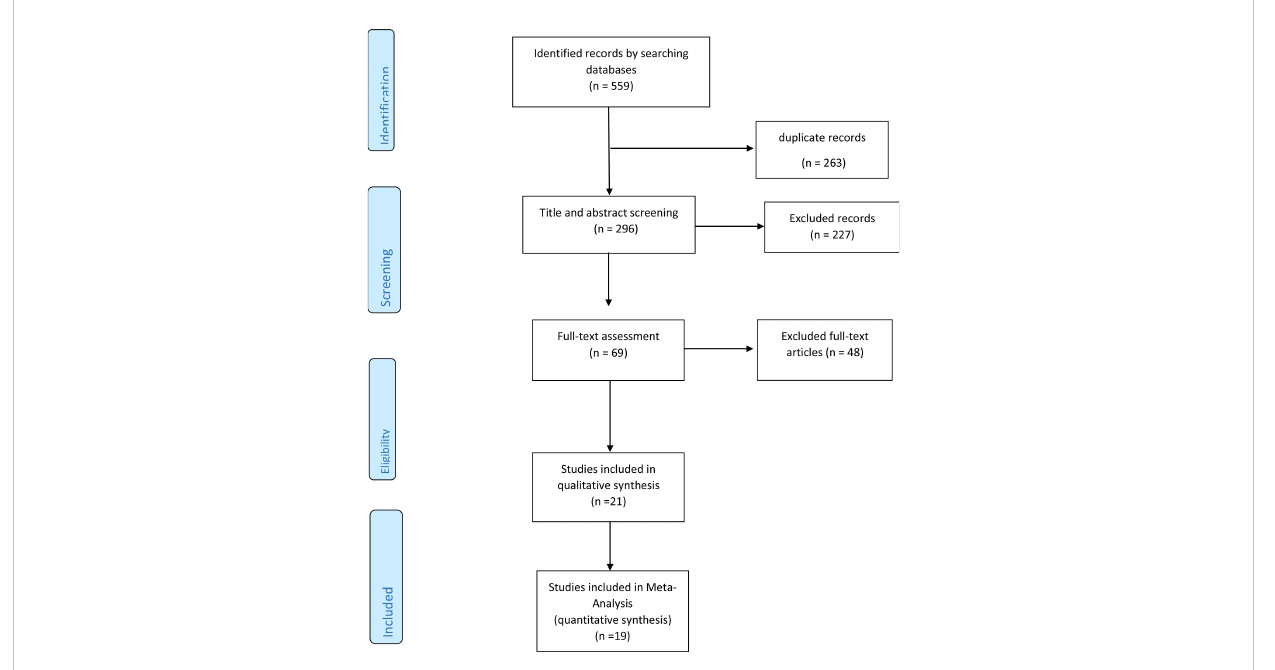
FIGURE 1 studies search, review and analysis fl